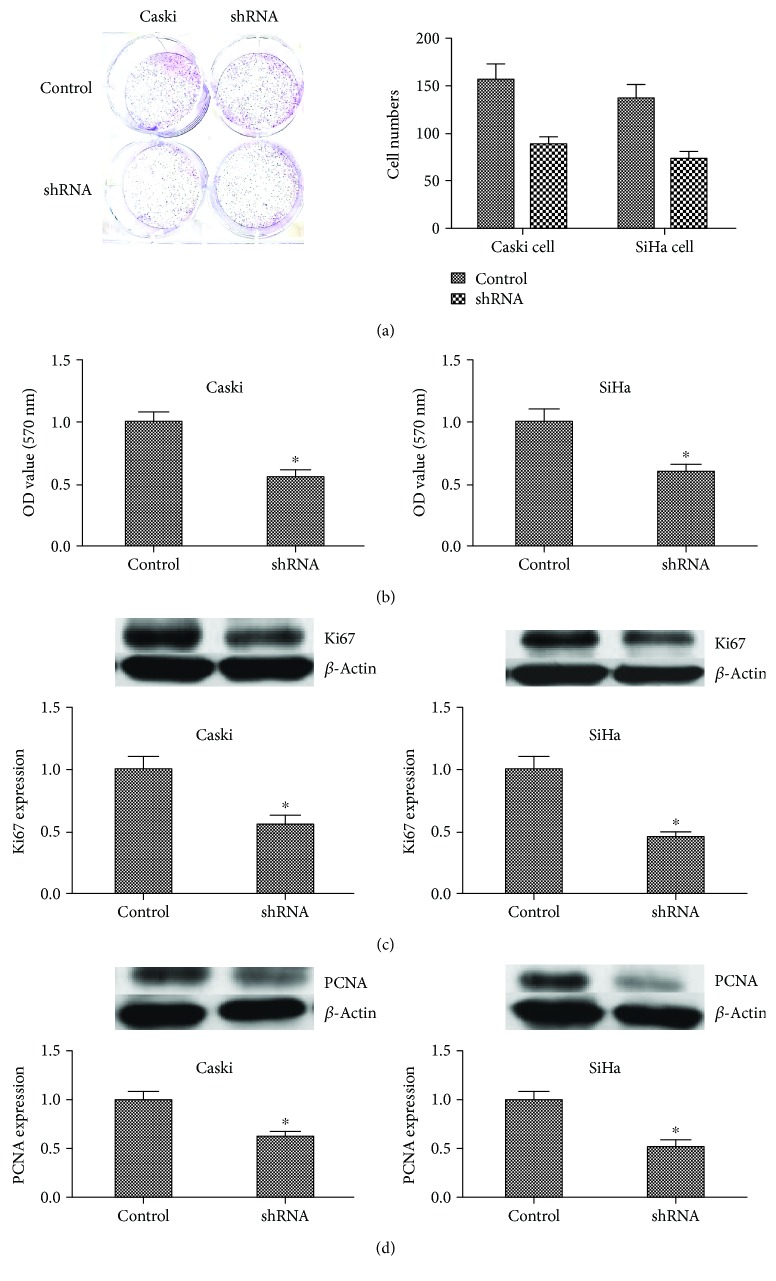
PTK7 regulated cell proliferation by Ki67 and PCNA proteins. (a) Colony formation assay. Results demonstrated that in Caski and SiHa cell lines, the control groups showed significantly higher survival fraction than the PTK7 knockdown groups (∗P < 0.05). (b) MTT proliferation assay. OD values were showed to be significantly lower in the PTK7 knockdown group compared to control groups (∗P < 0.05). (c, d) Western blot assay showed that the Ki67 and PCNA proteins were significantly downregulated in the PTK7 knockdown group compared to the control (∗P < 0.05).